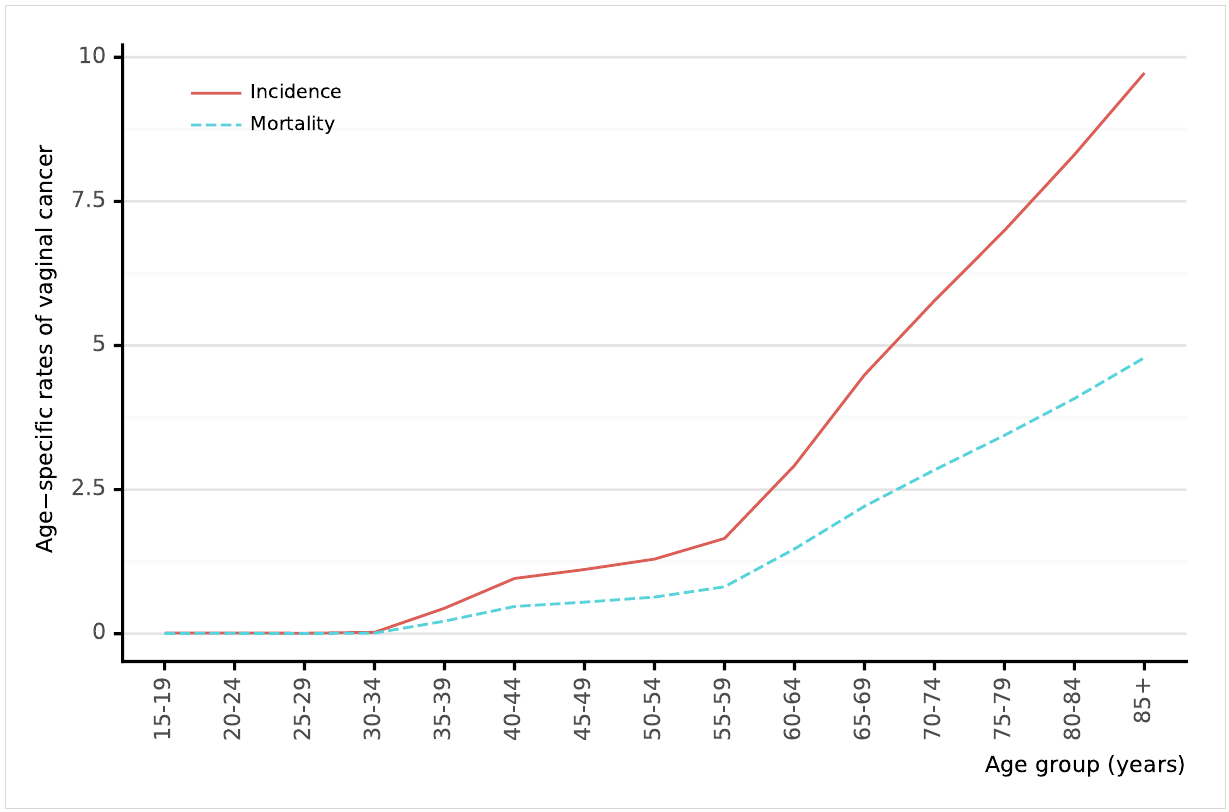
Figure 30: Comparison of age-specific vaginal cancer incidence and mortality rates in India